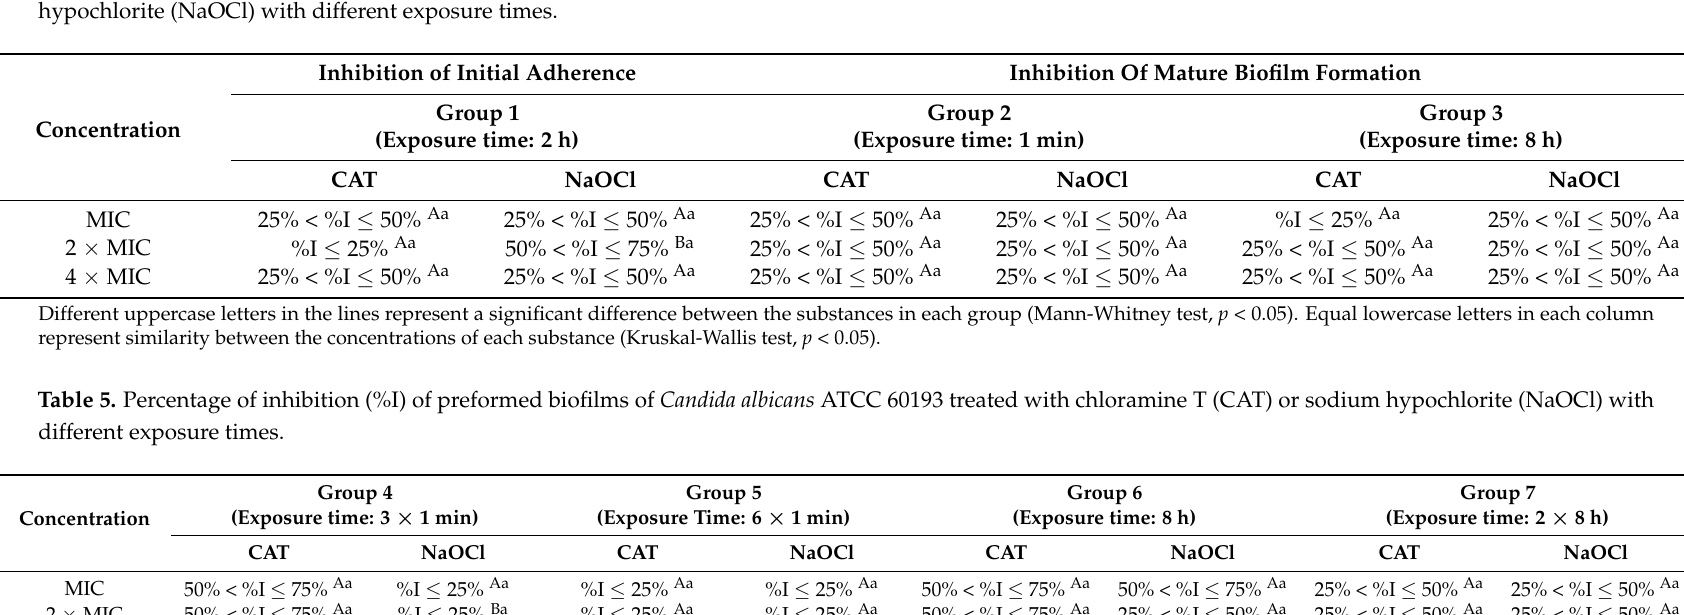
Table 4. Percentage of inhibition (%I) of adherence and mature biofilm formation of Candida albicans ATCC 60193 treated with chloramine T (CAT) or sodium hypochlorite (NaOCl) with different exposure times.